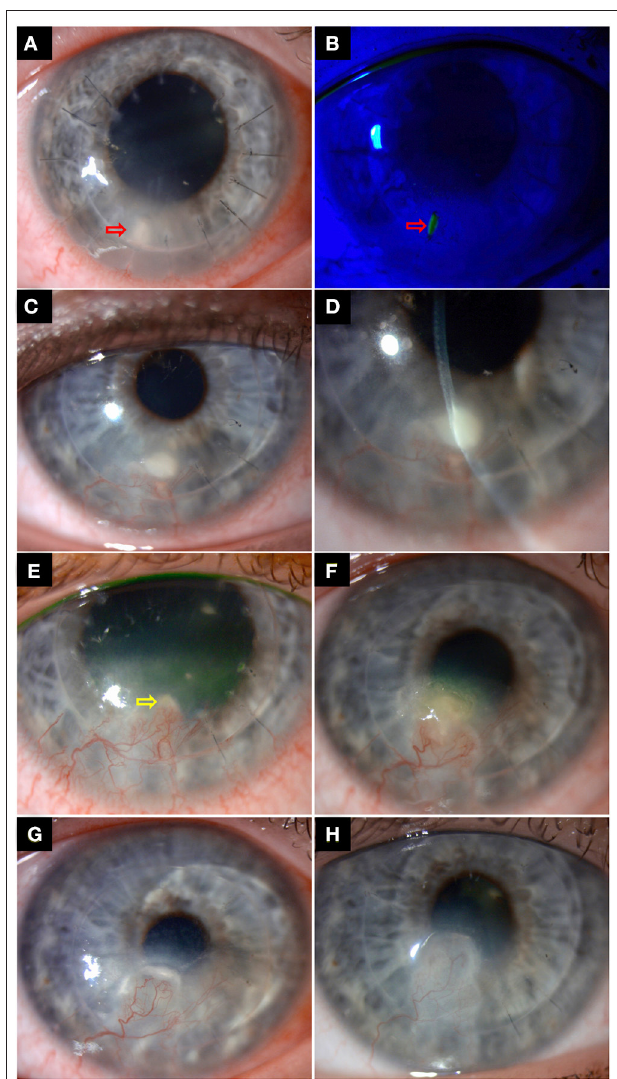
FIGURE 4 | A case of right recurrent interface infectious keratitis (IIK) after deep anterior lamellar keratoplasty (using manual dissection technique) for keratoconus. (A,B) Slit-lamp photography in Aug 2018 demonstrating a suture-related infection, with a mid-stromal infiltrate and a small overlying epithelial defect along the suture track at 7 o’clock (red arrows), with surrounding stromal oedema/folds. The infected broken suture was removed, and the infection was successfully resolved with topical antibiotic treatment. (C,D) A year later, slit-lamp photography showing a recurrent mid-to-deep stromal infiltrate (involving the graft-host interface) at the same site with inferior corneal graft vascularization, suggesting an atypical presentation of IIK. The recurrence was likely due to a “reactivation” of the previously treated infective nidus at the graft-host interface. (E) Improvement of the superficial infection was observed after two weeks of intensive antibiotic treatment. The residual IIK (yellow arrow) was resolved after a further 3 weeks of topical antibiotic treatment. (F) Further recurrence of infection was again observed in October 2020. Note the gradual migration of the infection towards the visual axis